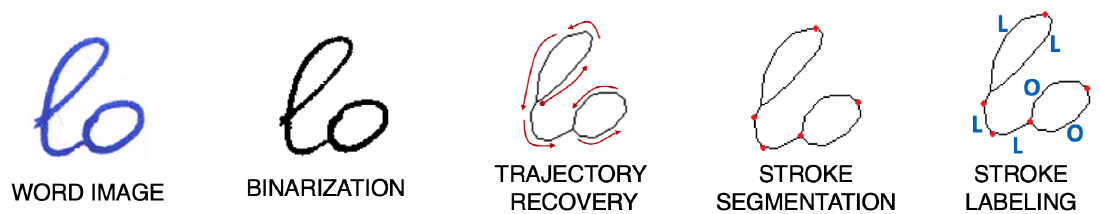
Figure 3. Each word image extracted from a document is processed by the query-by-string (QbS) retrieval system through the following steps: binarization [37], trajectory recovery [38], stroke segmentation [39] and, if a transcription is available for the word image, stroke labeling